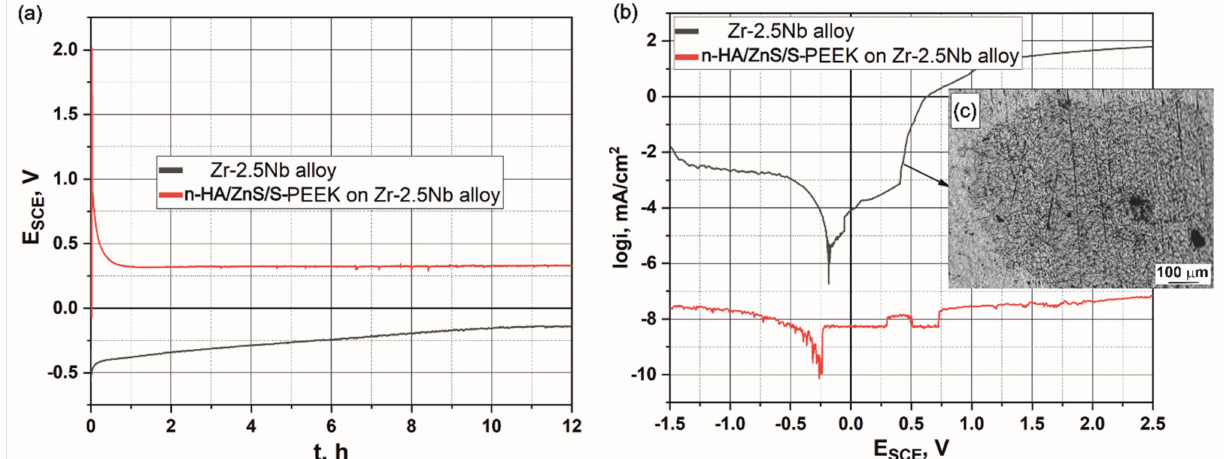
Figure 15. Electrochemical results for the Zr-2.5Nb alloy and the alloy coated with the n-HA/ZnS/S- PEEK coating in Ringer’s solution at 37 ◦ C, ( a ) OCP vs. time, ( b ) Anodic polarization curves at scan rate 1 mV/s and ( c ) light microscope image of the alloy surface after the LSV experiment.